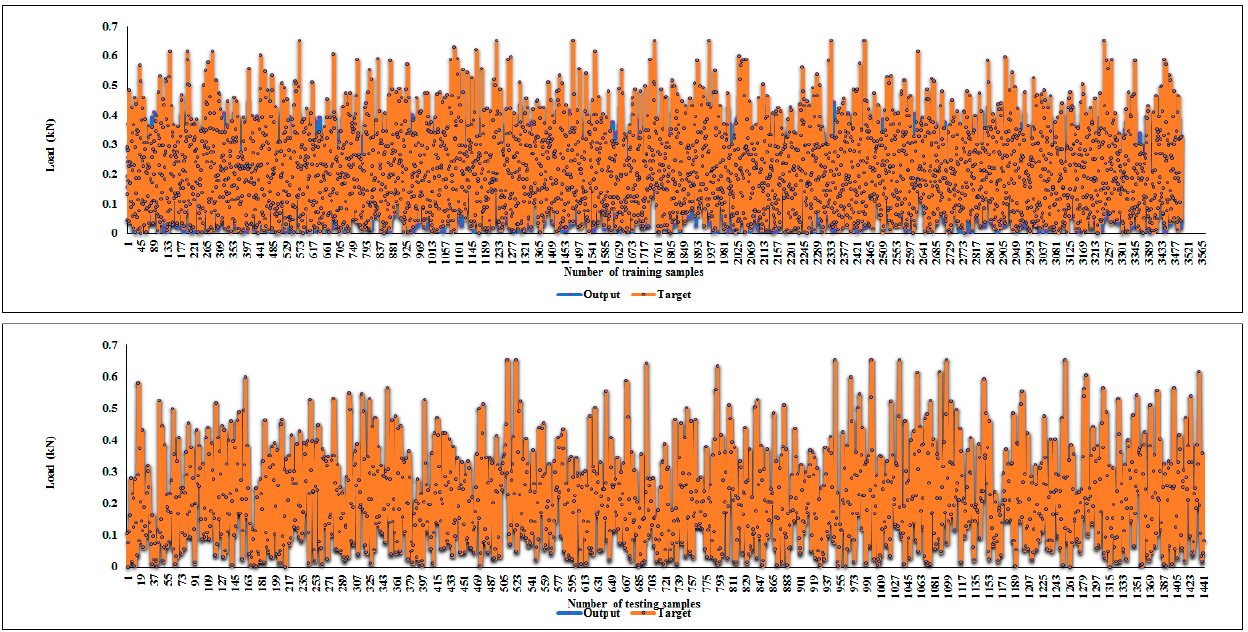
Figure 28. The MPF (five inputs) prediction vs experimental diagram for ultimate load: ( above ) training phase, ( below ) testing